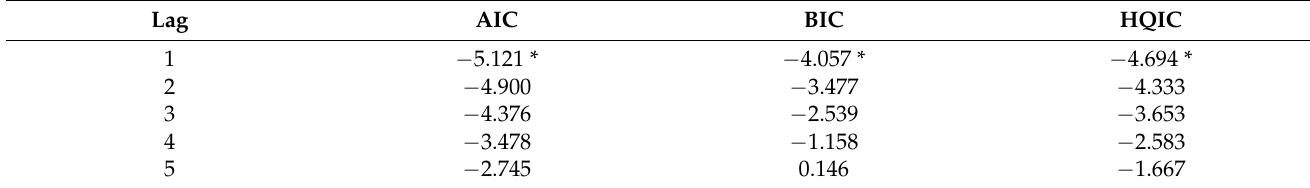
Table 9. Optimal lag order.